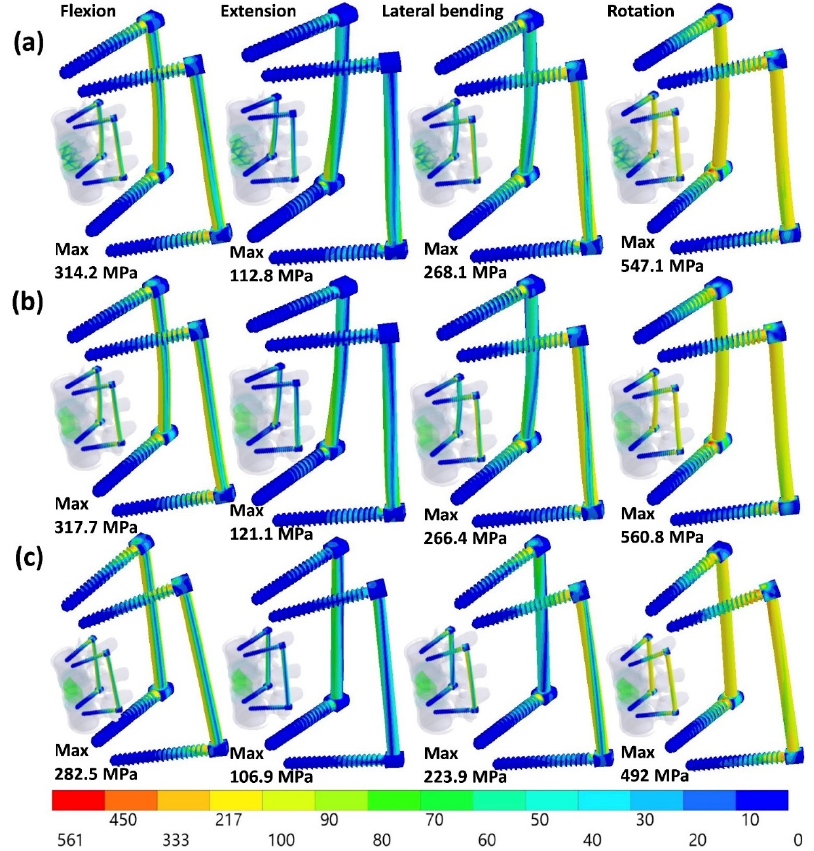
Figure 11. The equivalent stress of the PI in CCSJPI ( a ), CCPI ( b ), and ICPI ( c